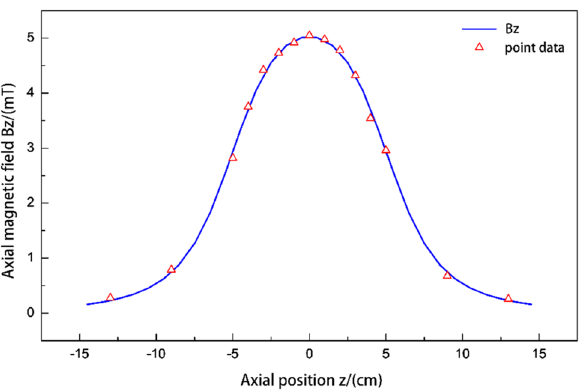
Figure 5. The magnetic field on the central